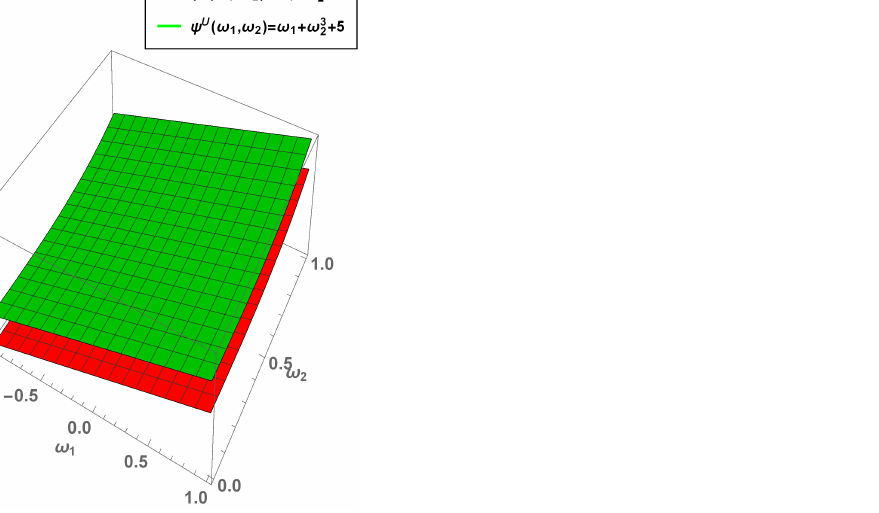
Figure 2. Graphical view of the objective functions Ψ L ( (cid:118) 1 , (cid:118) 2 ) and Ψ U ( (cid:118) 1 , (cid:118) 2 ) of the problem